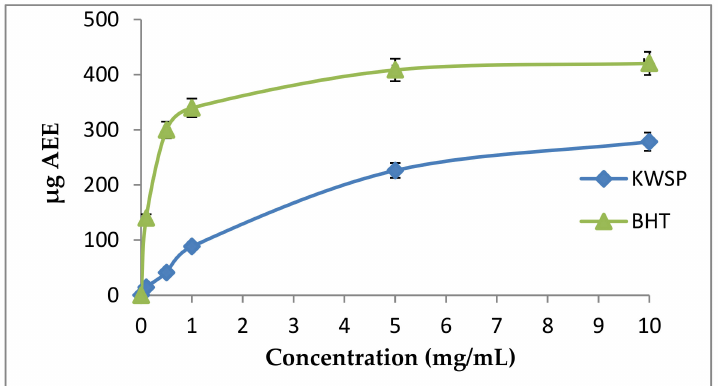
Figure 11. Total antioxidant activity according to the concentration of polysaccharide. Each point represents the mean of three independent experiments (SD < 10% of the